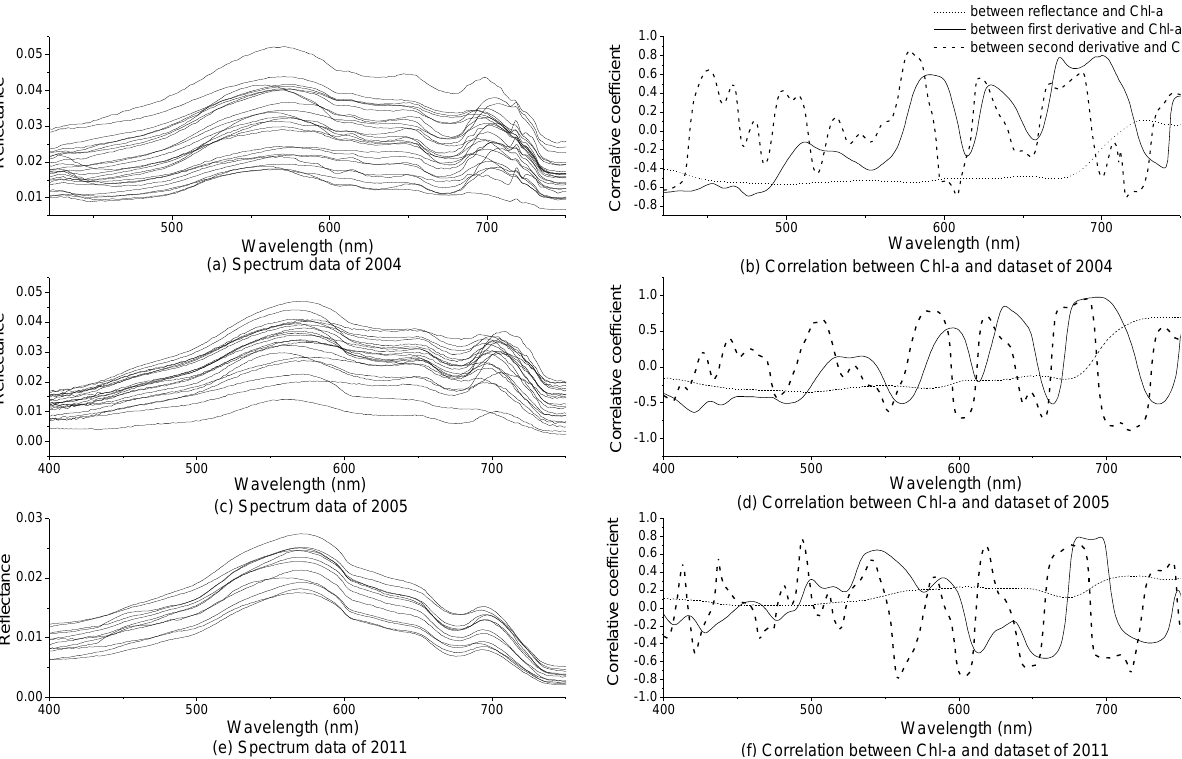
Figure 3. The original spectrum in ( a ) 2004, (c) 2005, and ( e ) 2011, and the correlation coefficients between Chl-a and the original reflectance, first-order spectral derivative and second-order spectral derivative in ( b ) 2004, ( d ) 2005, and ( f )